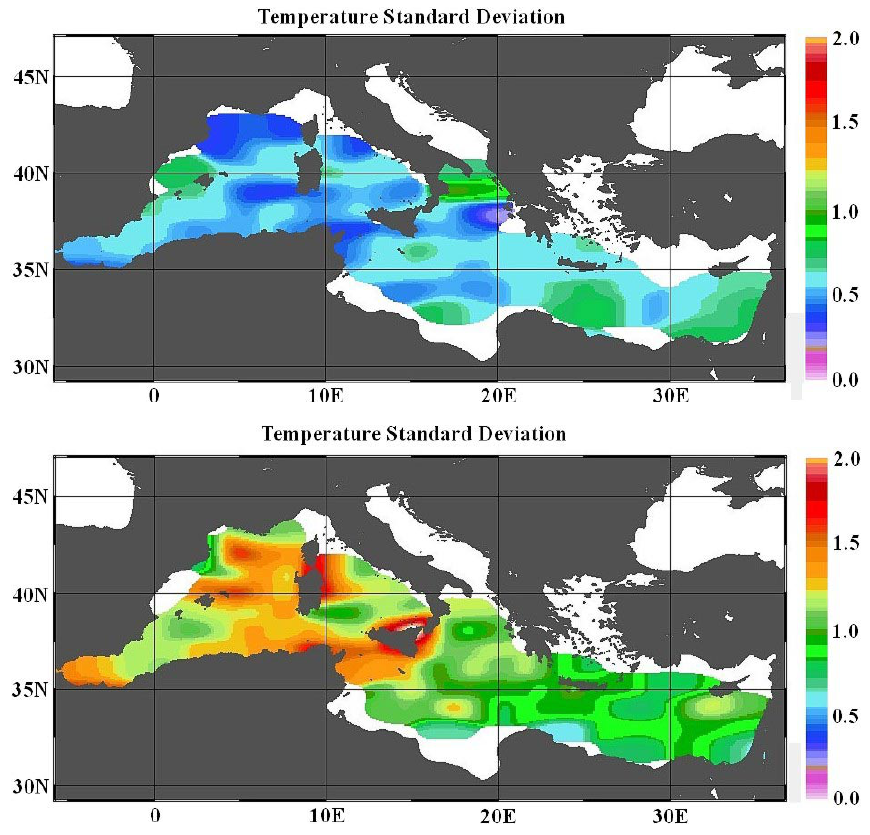
Fig. 7. Climatological standard deviations at surface in January (a) and July (b) . Deviations at 5m